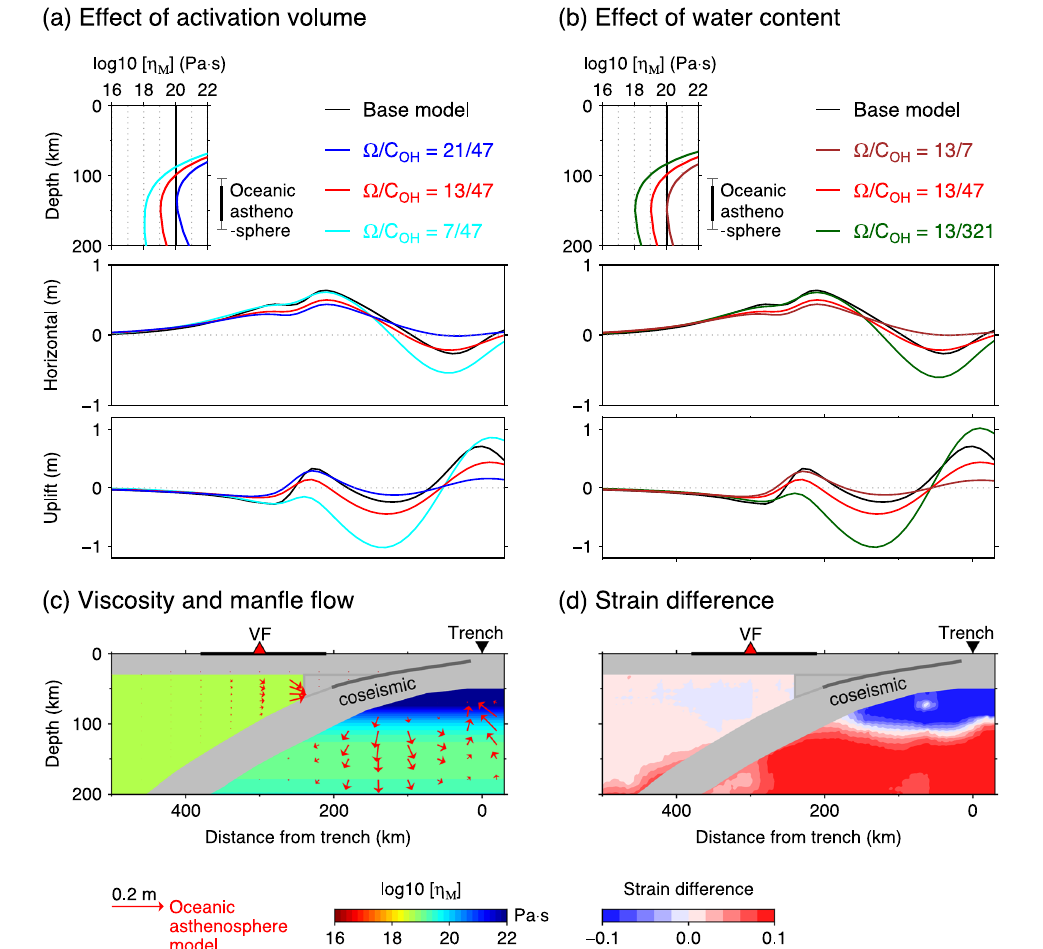
Fig. 7 The effect of oceanic asthenosphere on the 3-year postseismic deformation a The surface displacement by the model with activation volume ( �) vary as ~ 21, ~ 13, and ~ 7 cm 3 /mol while water content (C OH ) was fixed to 47 ppm H/Si. The corresponding 1-D viscosity profiles are shown in top panel. b The surface displacement by the model with C OH vary as ~ 7, ~ 47, ~ 321 ppm H/Si while (cid:31) was fixed to ~ 13 cm 3 /mol. The corresponding 1-D viscosity profiles are displayed in top panel. See model details in Additional file 1: Table S3. c The trench-normal profile shows the viscosity distribution and mantle flow pattern for the model with (cid:31) ~ 13 cm 3 /mol and C OH 47 ppm H/Si are shown. d The distribution of strain = = difference corresponds to the model shown in ( c ). Strain difference strain in depth-dependent model – strain in base model. All viscous strain = (second invariant of the deviatoric strain tensor) is normalized by the coseismic